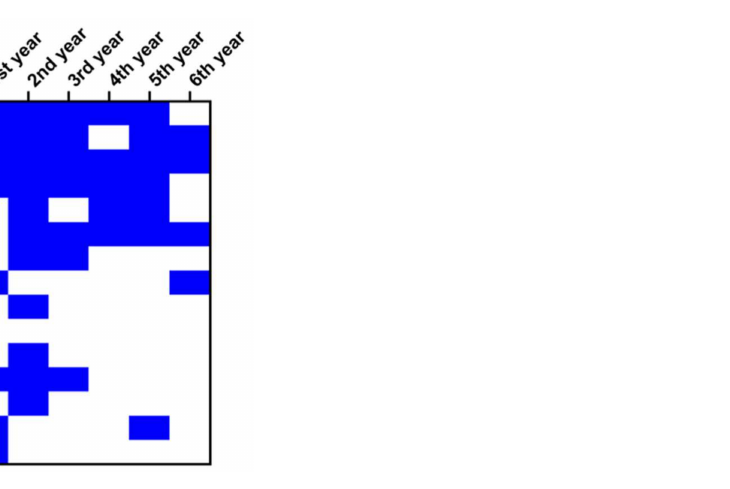
Figure 3. Heat map showing the frequencies with which the Polish medical schools teach the medical humanities courses. Blue color—a course offered; white color—course not offered. The universities are coded with numbers, and the coding is the same as in Table 1. Some universities offered classes under the same name (suggesting continuity of the teaching program) during each semester of study, whereas others implemented a class only once during the course of the medical program. Table 1 summarizes the information about specific classes. The names of the universities were replaced with random numbers. Table 1. Short description of courses, including course name, the total number of teaching units per duration of the whole medical program (6 years), and evaluation methods. The information was extracted from the publicly available study program. The universities are coded with numbers the same as Figures 3 and 4. OSCE—Objective Structured Clinical